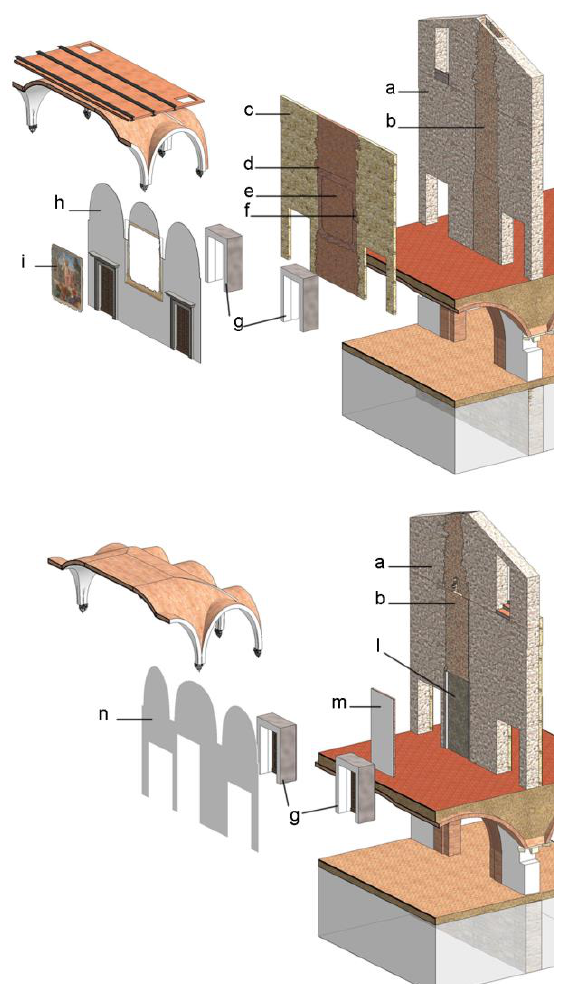
Figure 6. The BIM model. Exploded view: a. the main wall; b. the chimney and the fireplace; c. the counter-wall of the painting; d. the boundary filling of the solid-wall; e. the solid- wall of the painting; f. the support block of the “peduccio”; g. the reinforcement of the two side doors; h. the plaster; i. the painting; l. the incoherent filling of the fireplace; m. the closure at the back of the fireplace; n. the plaster.